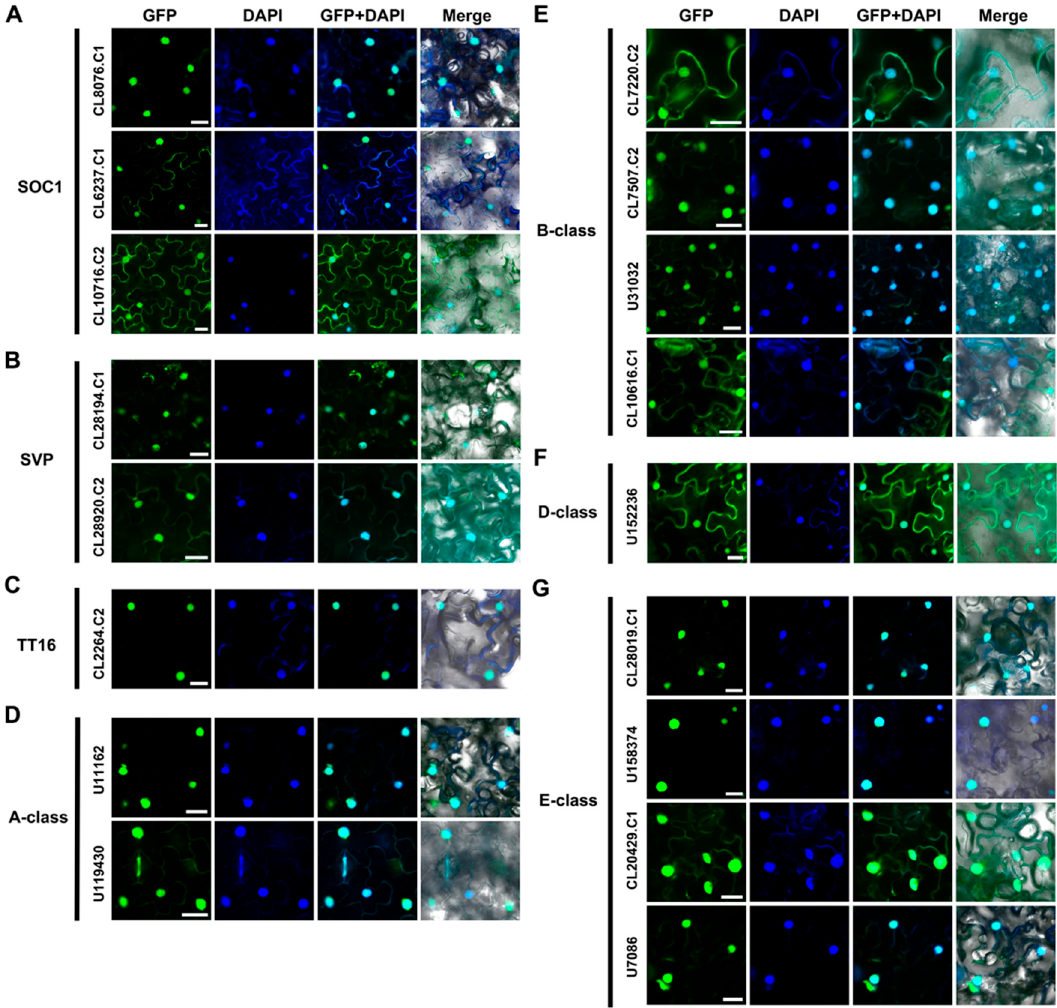
Figure 5. Subcellular localization of 17 AaMADS fused with green fluorescent protein (GFP) in tobacco leaves. The 17 AaMADS belonged to the SOC1 type ( A ), SVP type ( B ), TT16 type ( C ), A-class ( D ), B-class ( E ), D-class ( F ), and E-class ( G ) groups, respectively. GFP fluorescence is green and the nuclear dye DAPI is blue. Merge is created by merging the GFP, DAPI, and bright-field images. Scale bar = 10 µm.